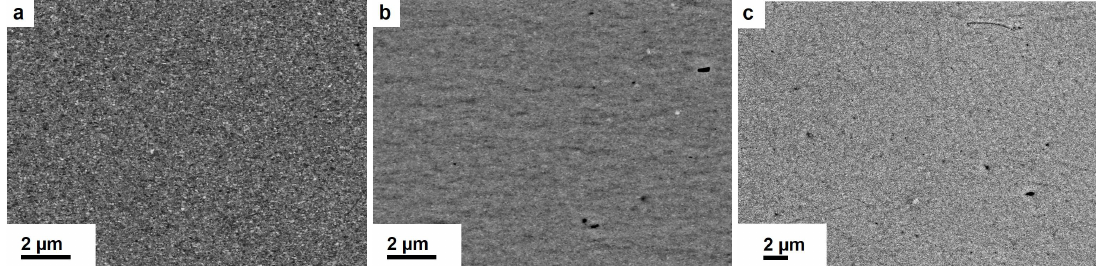
Figure 3. BSE micrographs of as-deformed Fe-based samples at r ≥ 2 mm along the tangential direction. The microstructure of Fe7wt.%-Cu ( a ) appears homogenous. Fe25wt.%-Cu ( b ) exhibits some remaining particles embedded in a highly homogeneous matrix. Fe18wt.%-Ag ( c ) shows high contrast variations indicating less Fe dissolved in the Ag-matrix.